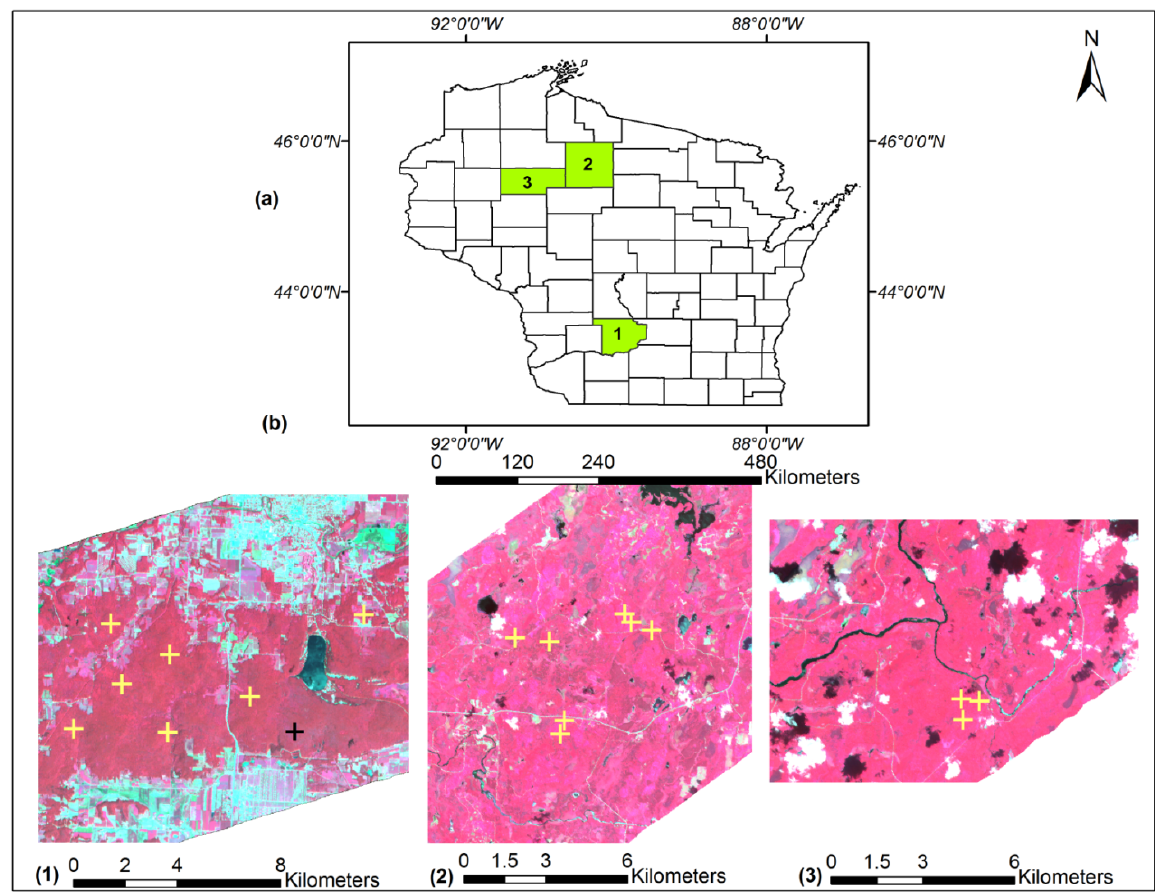
Figure 1. Study area: ( a ) State of Wisconsin, USA, showing different counties. The general location of the three field sites are shown in green; ( b ) Plot location overlaid on a false color composite from the AVIRIS image (red: 860 nm; green: 667 nm and blue: 540 nm). Black cross shows a plot which was removed as an outlier from the final